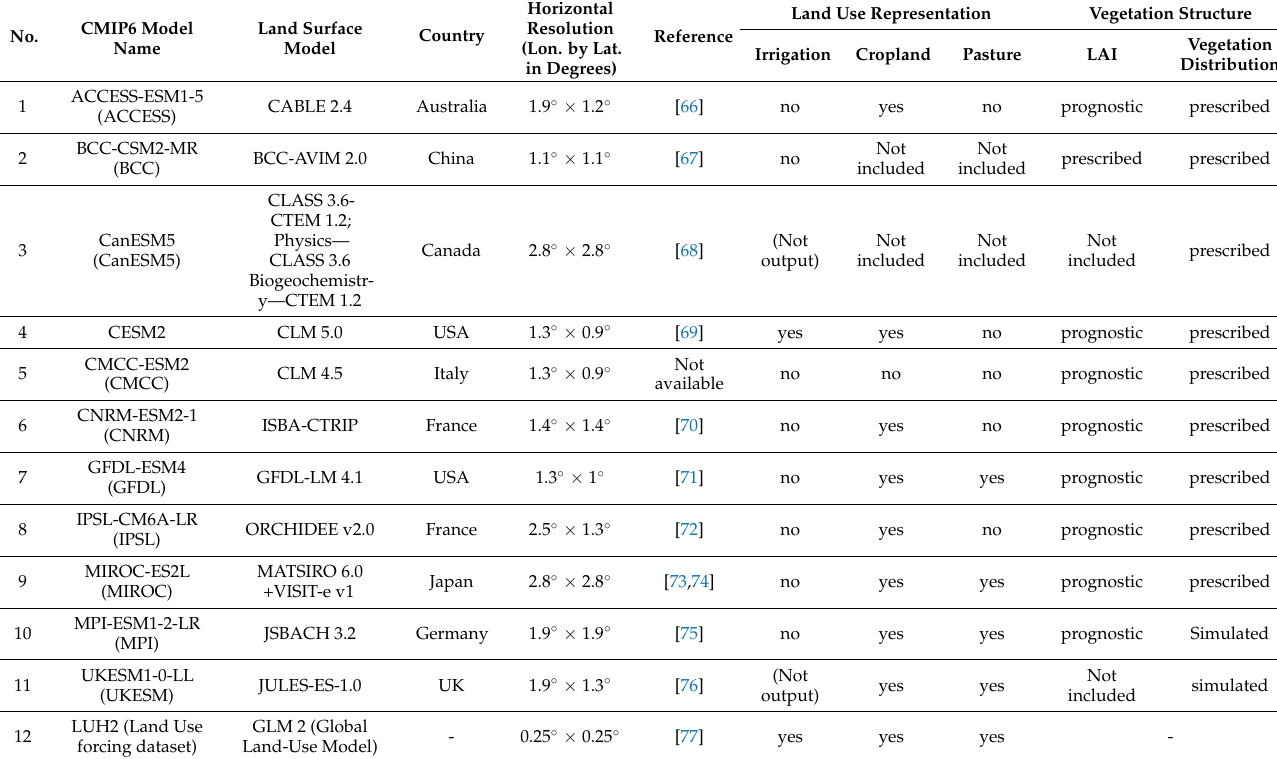
Table A1. CMIP6-GCMs model description.